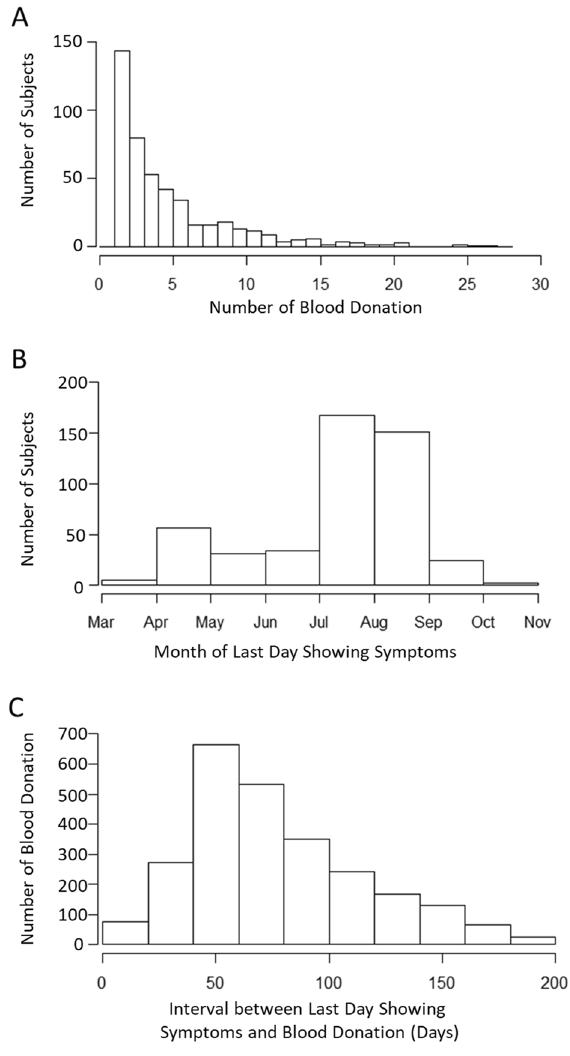
Figure 1. Distribution of COVID-19 patients with multiple blood donation. ( A ) Distribution of the number of blood donations from COVID-19 patients. ( B ) Distribution of patients with their last days showing COVID-19 symptoms. ( C ) Distribution of the time interval between the last day showing symptoms and the latest day of blood